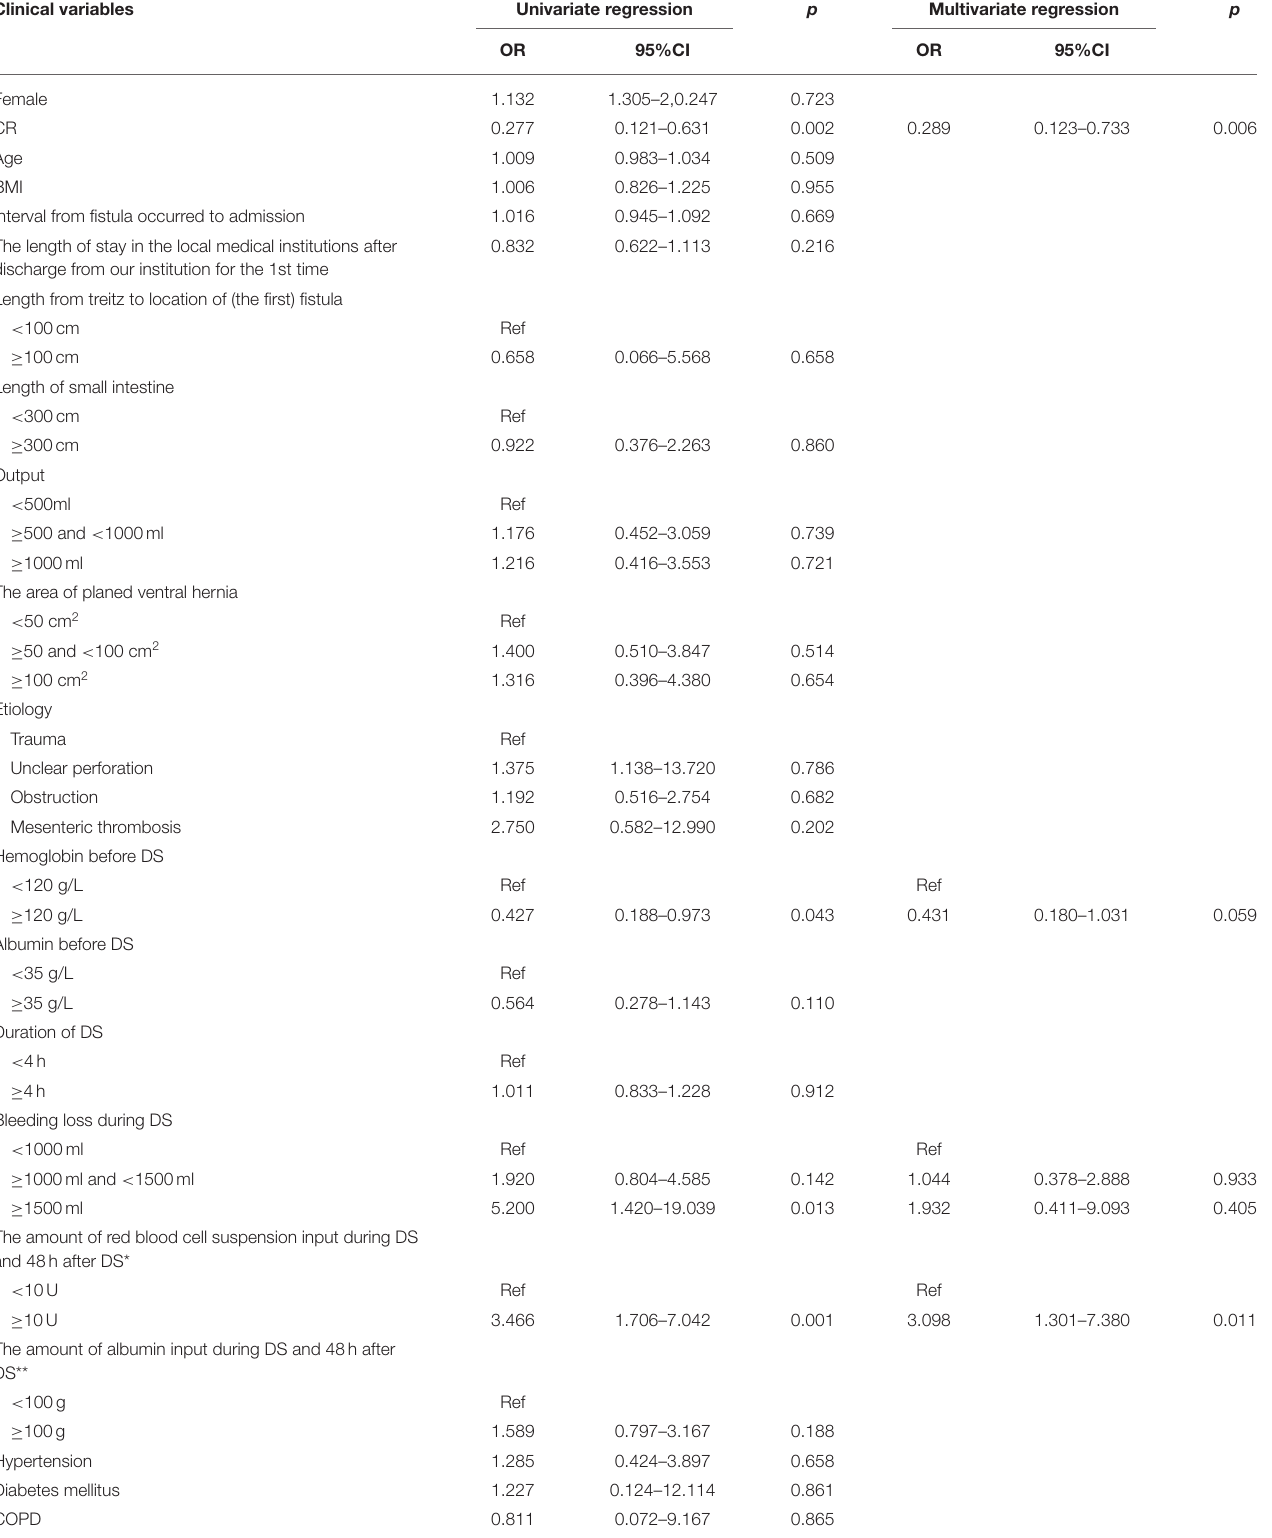
TABLE 5 | Logistic regression analysis of the risk factors for postoperative complications before